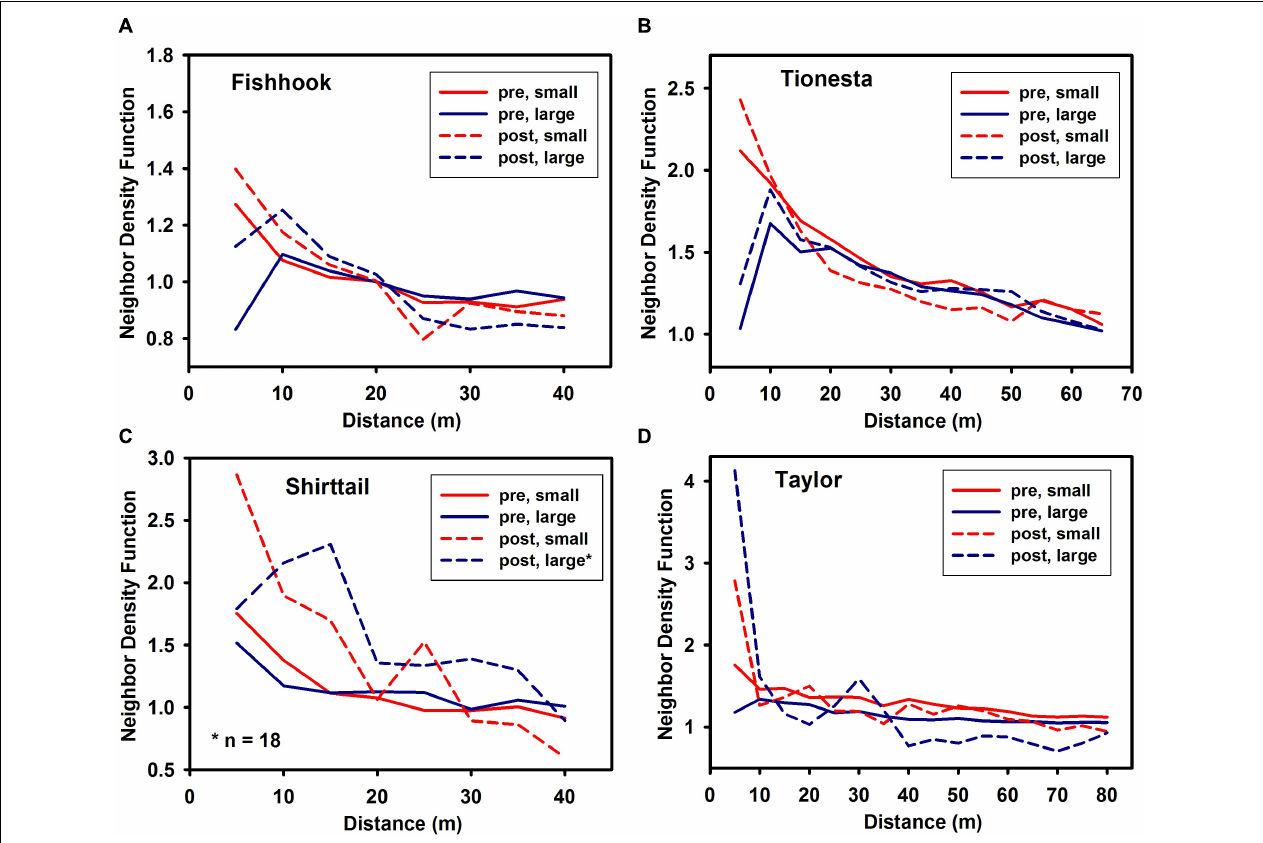
FIGURE 3 | Neighbor density function of trees smaller than (‘small’) and larger than (‘large’) the site (pre-disturbance) median dbh in pre-disturbance and post-disturbance stands at the four sites. Pre-disturbance NDF shown with solid lines; post-disturbance NDF shown with dashed lines. (A) Fishhook; (B) Tionesta; (C) Shirttail; and (D) Taylor. Note that x and y axes differ among the panels in this figure. Confidence intervals omitted for clarity; a value of unity on the y axis corresponds to complete spatial randomness. Values greater than unity are more aggregated than random; values less than unity are more uniform than random.